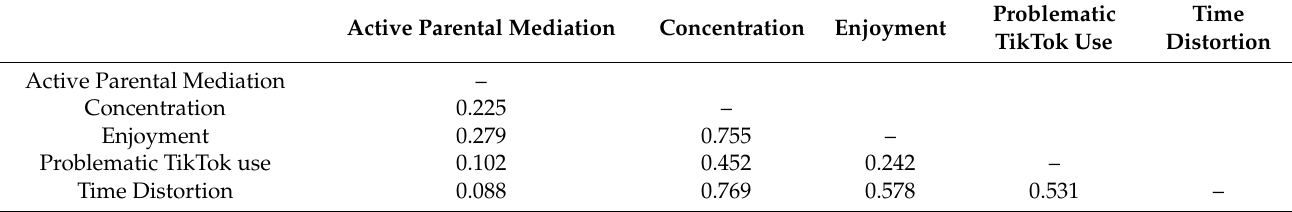
Table 5. Discriminant Validity: Heterotrait Monotrait (HTMT)